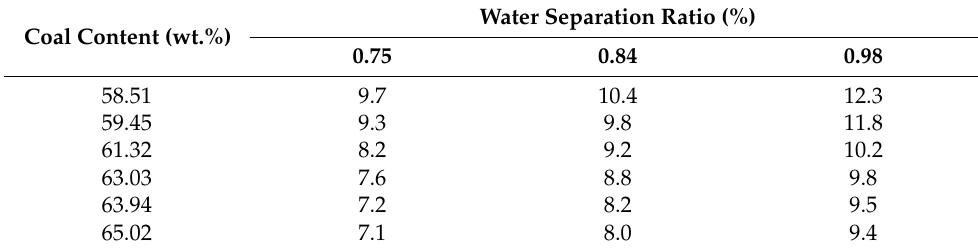
Table 5. Water separation ratio (WSR) of CWS stored still for 7